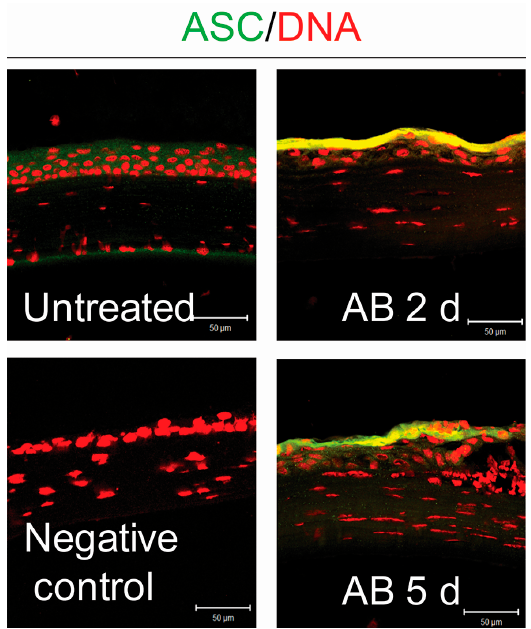
Figure 2. Upregulation of apoptosis-associated speck-like protein (ASC) in corneal epithelium of animals subjected to alkali burns (AB) at 2 days (2 d) and 5 days (5 d) post-injury. Representative merged digital images of laser scanning confocal microscopy in corneal cryosections immunostained for ASC (green) with propidium iodide nuclei counterstaining (DNA in red) in corneas subjected to alkali burn ( n = 6 animals/group). Scale bar: 50 µm.